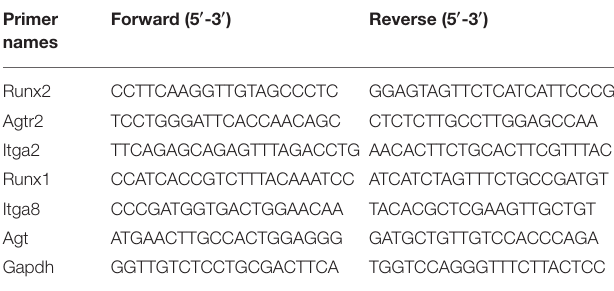
TABLE 1 | Primers of quantitative real-time